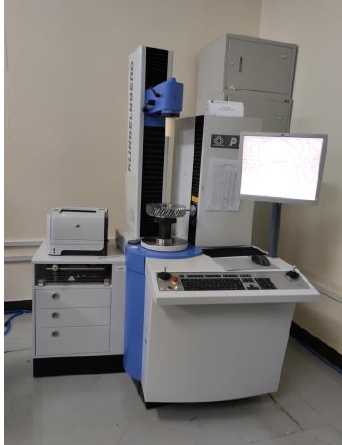
Figure 11. Gear measurement center (P26, Klingelnberg, Ettlingen, Germany).